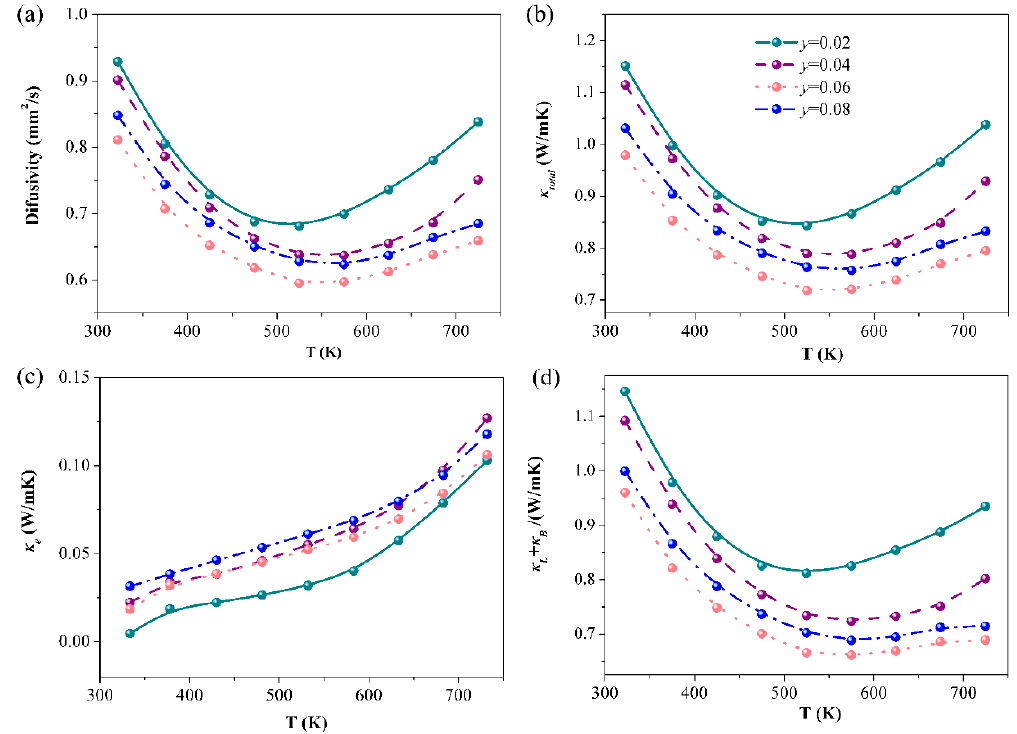
Figure 6. The thermal diffusion coefficient, D ( a ), the total thermal conductivity, κ total ( b ), electronic thermal conductivity, κ e ( c ), as well as bipolar and lattice thermal conductivity, κ L + κ B ( d ), as a function of the temperature for Eu 5 − y La y In 2.2 Sb 6 ( y = 0.02, 0.04, 0.06, 0.08).